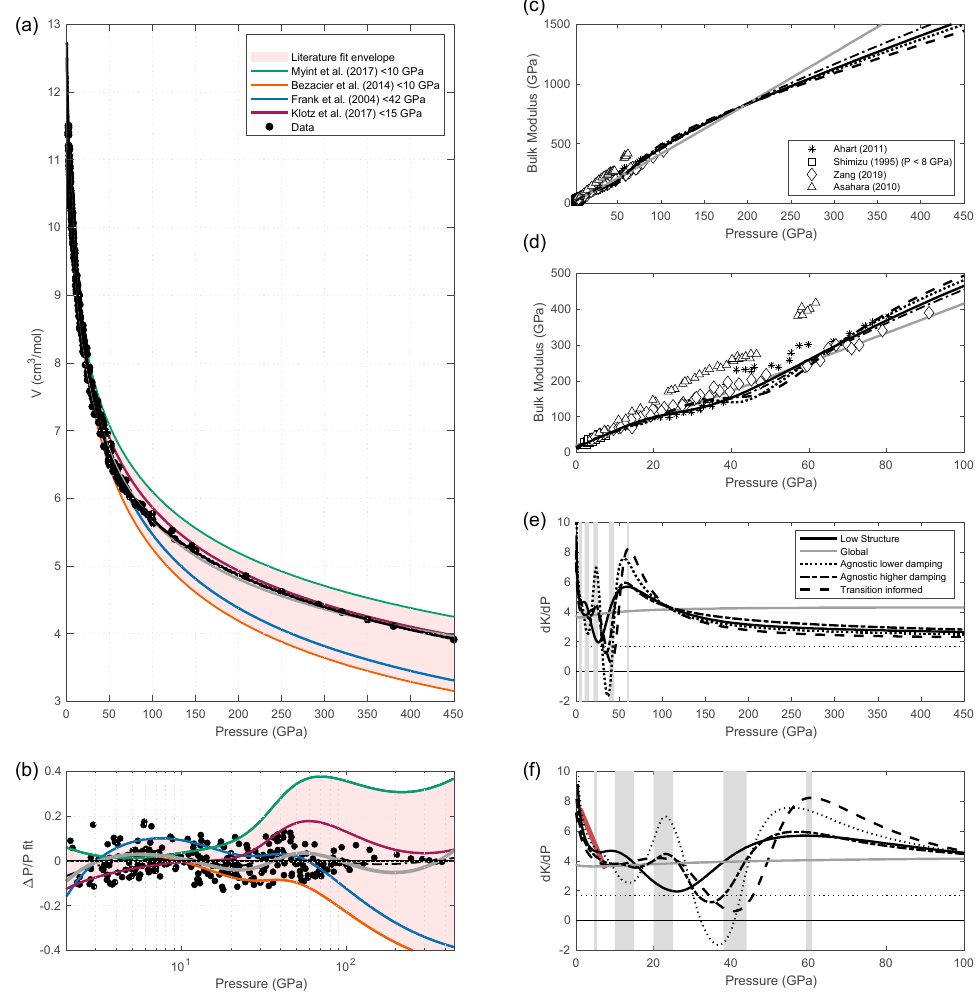
Figure 2. Data and equations of states of ice VII and X at 300K. In all panels, predictions based on the “low structure” local-basis-function (LBF) are shown with thick solid lines, the dotted and dot-dashed lines are the “agnostic” LBFs with lighter or heavier damping, the dashed lines are “transition informed”, the gray lines are the global fourth-order fit. ( a ) Specific volume as a function of pressure. All measurements are represented with solid circles. Prior fits are identified in the legend. ( b ) Residuals relative to the preferred LBF representation as a function of the logarithm of pressure. ( c , d ) Bulk moduli as a function of pressure. All symbols are identified in the legend. ( e , f ) Pressure derivative of the bulk moduli for the four current representations. The 5 / 3 limit for high-pressure behavior of K’ in represented as a horizontal dotted line. The behavior of K’ based on a quadratic fit to Shimizu et al. [60] is shown for pressures between 2 and 8 GPa a thick line. Vertical bars indicate identified pressure ranges (Table 1) for higher order